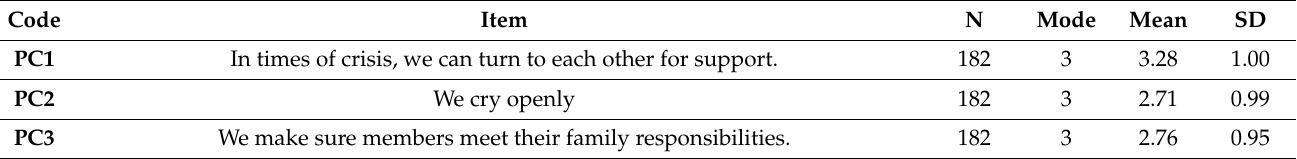
Table 5. Descriptive statistics for the survey